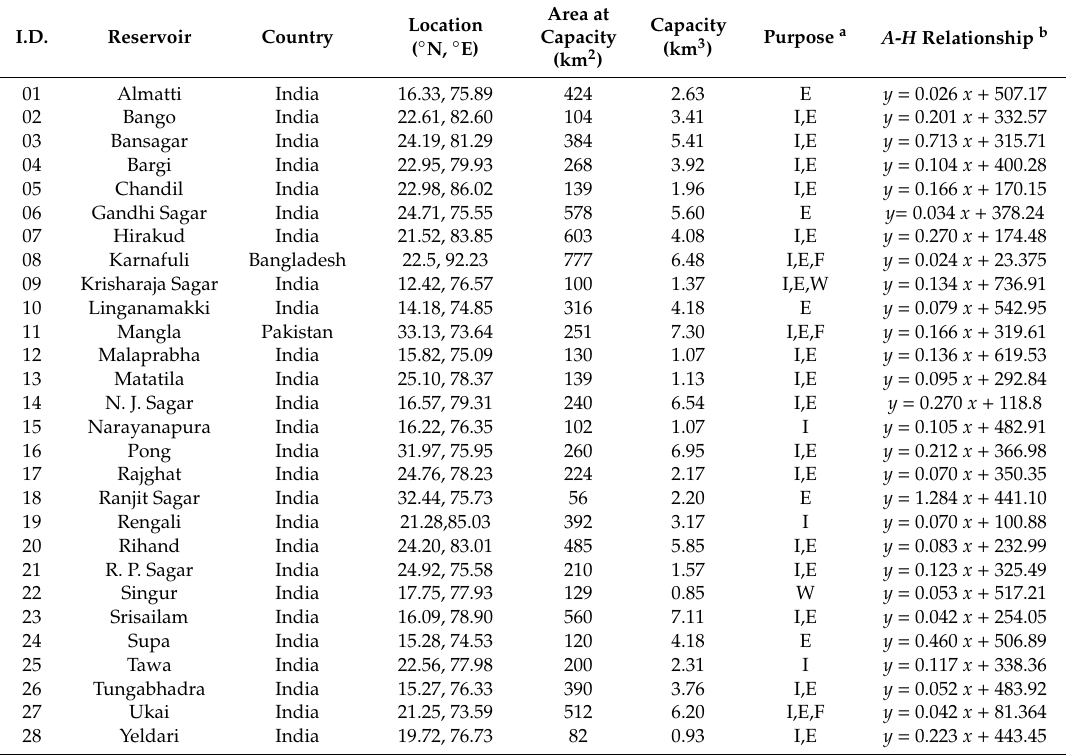
Figure 1. Locations of 28 reservoirs that can be monitored using a remote sensing approach. Yellow dots represent reservoirs that can only be monitored by the Moderate Resolution Imaging Spectroradiometer-Ice, Cloud, and Land Elevation Satellite (MODIS-ICESat). Green dots are reservoirs that can only be monitored through the MODIS-Shuttle Radar Topography Mission (STRM). Red points are reservoirs that can be monitored by both approaches. For each reservoir, detailed information is provided in Table 1. Table 1. Detailed information for the 28